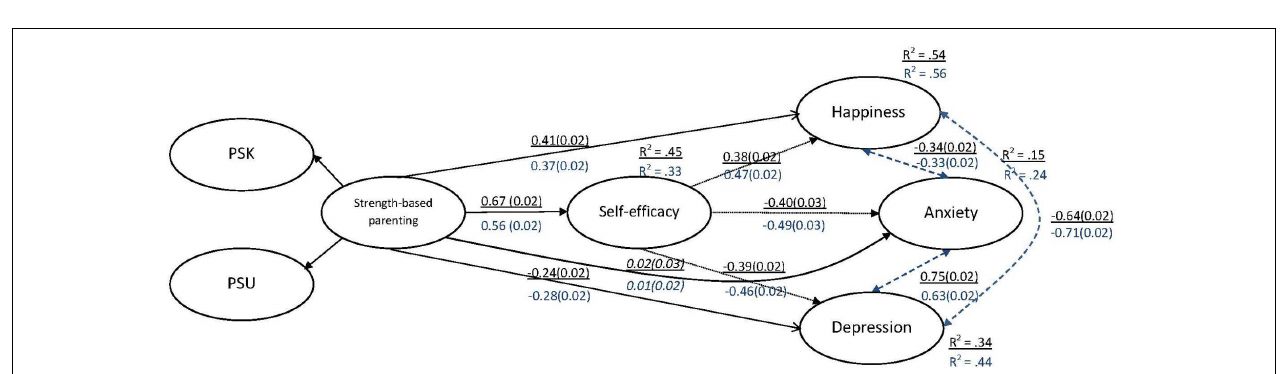
FIGURE 3 | Multigroup analysis of the mediation model across gender. Simultaneously estimated, standardized β weights for the partial invariance mediation model across gender are depicted, with standard error of β in parentheses. Underlined parameters represent the estimates for females, and non-significant ( p > 0.05) pathways are denoted in italics. For convenience indirect effects are denoted by dotted lines and correlations by dashed lines. Indicators of the latent factors are not displayed for brevity. PSK, parental strength knowledge; PSU, parental strength use.